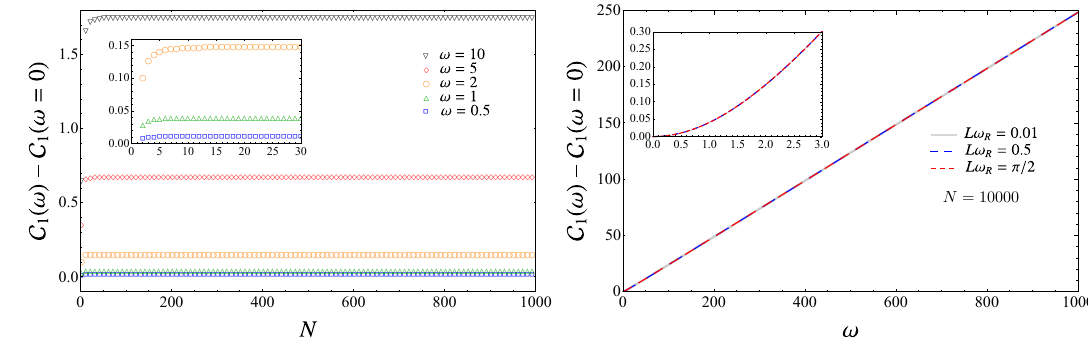
Figure 3 . The complexity C 1 when ! 6 = 0 with respect to the massless result (3.11). In the left panel we show that for large N this di(cid:11)erence is a constant depending on ! (here L! R = 0 : 5). In the right panel the dependence on ! is shown for N =